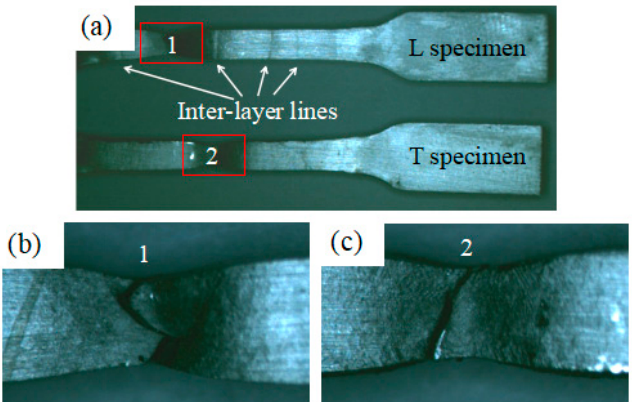
Figure 16. Macroscopic fracture appearance of tensile specimens. ( a ) Longitudinal and transversal specimens after fracture; ( b ) macroscopic fracture of longitudinal specimen; ( c ) macroscopic fracture of transversal specimen.